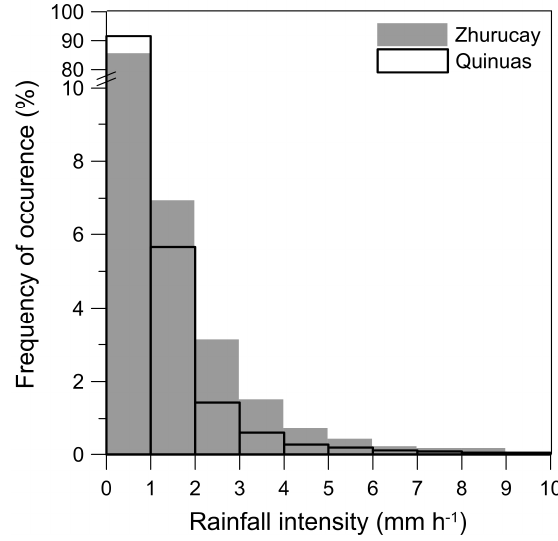
Figure 1. Rainfall intensity distribution in the páramos of Zhurucay and Quinuas.